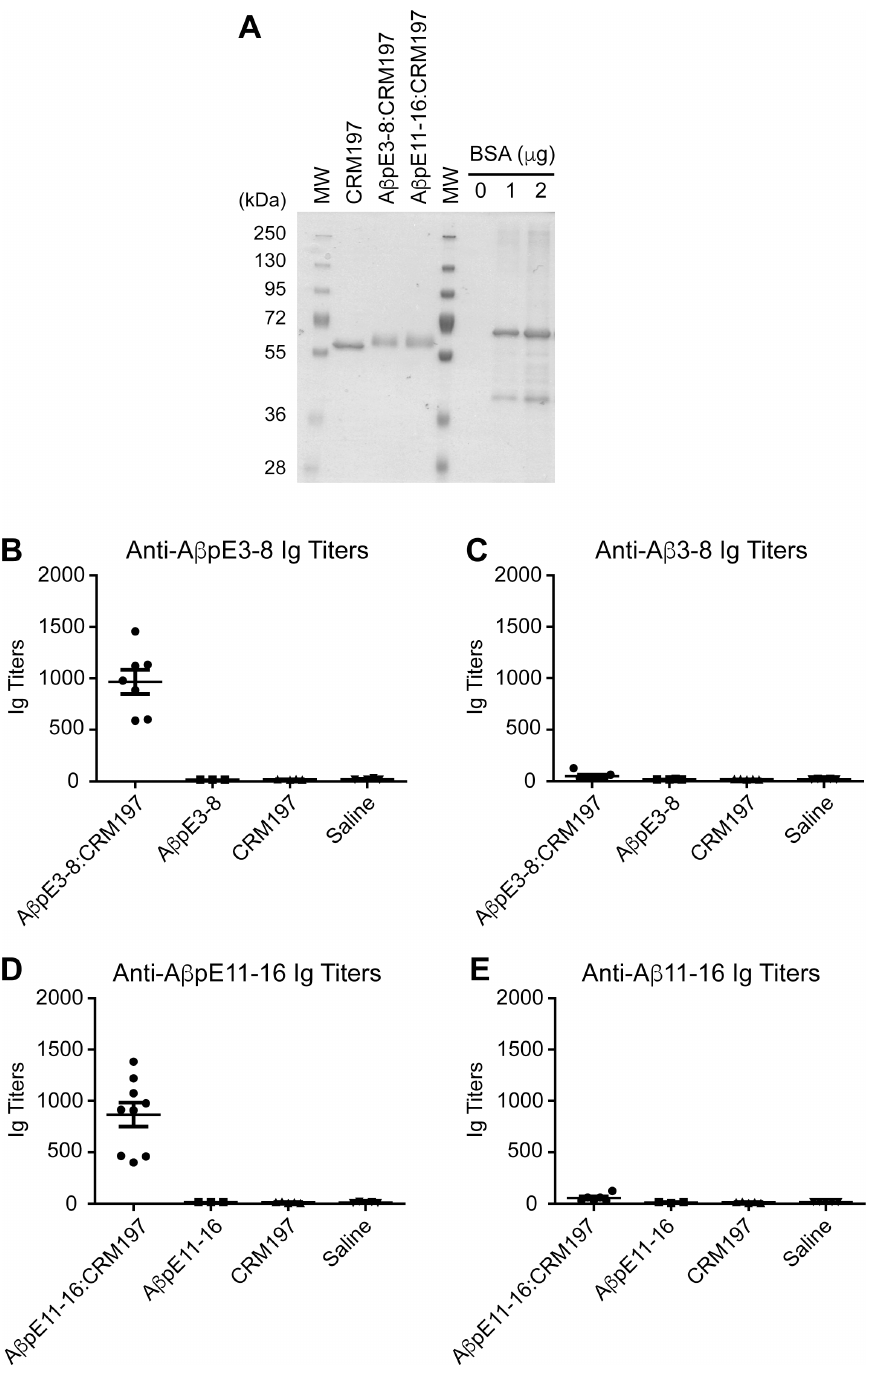
Figure 2. Anti-A β pE3-8 and anti-A β pE11-16 antibody response. (A) Coomassie blue stain- ing of CRM197 alone or conjugated to A β pE3-8 (A β pE3-8:CRM197) or A β pE11-16 (A β pE11- 16:CRM197). (B) Anti-A β pE3-8, (C) anti-A β E3-8, (D) anti-A β pE11-16 and (E) anti-A β E11-16 Ig titers in sera obtained from mice immunized with A β pE3-8 or A β pE11-16 conjugated (A β pE3-8:CRM197, A β pE11-16:CRM197) or not (A β pE3-8, A β pE11-16) with CRM197. Data represent mean ± standard error of the mean from three to nine mice per group. MW, molecular weight